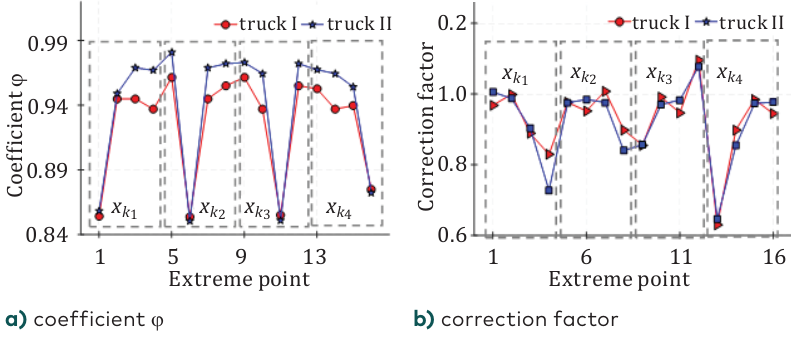
a) coefficient j b) correction Figure 9. Comparative analysis of different axle parameters